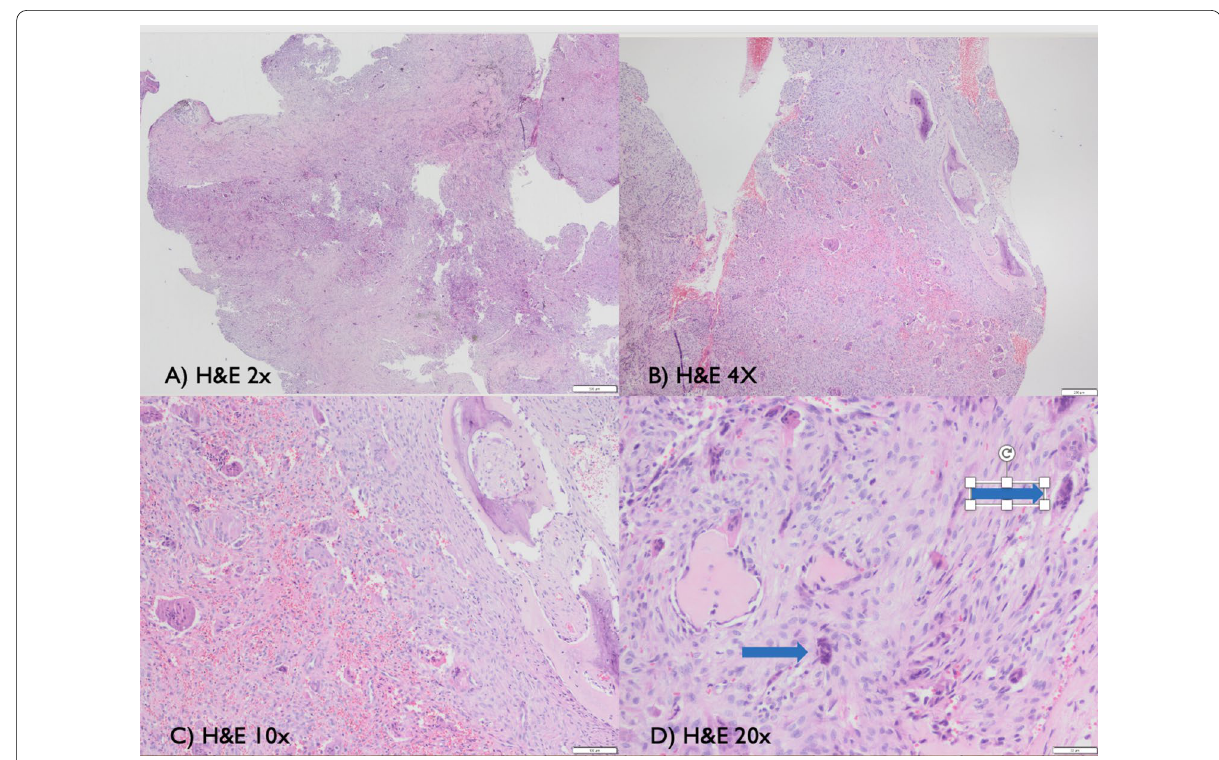
Fig. 6 Histopathological images at different magnifications. A Hematoxylin and eosin with magnification, C Hematoxylin and eosin with